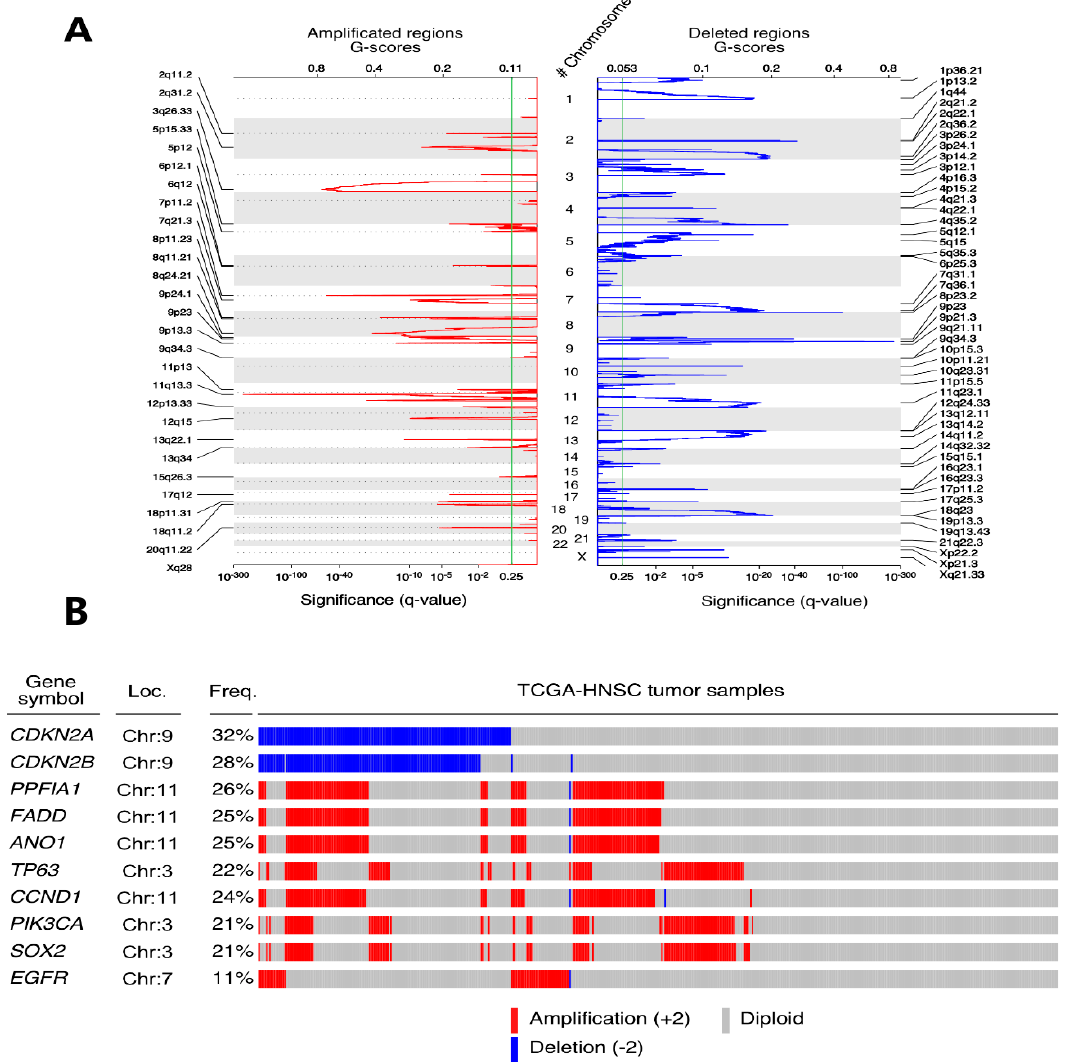
Figure 3. The GISTIC algorithm results reveal alterations of different genes at copy number level. ( A ) The chromosomal location of these alterations is represented as peaks in which the height over the χ -axis represents the significant q -value calculated and the width on the Υ -axis is associated with the genomic extension affected by this change. ( B ) The Top COSMIC cancer gene census list altered in the TCGA-HNSCC cohort are represented in the oncoplot. Blue is associated with a deep deletion in a patient of a particular gene whereas red represents a deep amplification. The chromosome location is provided as well as the percentage (%) of patients affected with each gene’s somatic copy number alteration (SCNA) in the cohort.